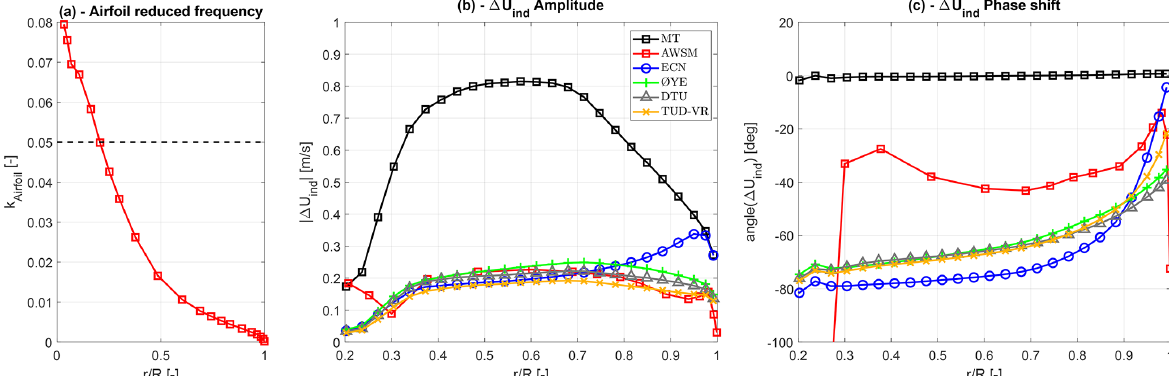
Figure 7. Spanwise distributions for the 50mHz sinusoidal pitch variation near rated conditions (a) of the reduced airfoil frequency; (b) of the axial induced-velocity variation amplitude at the blade pitch frequency; and (c) of the axial induced-velocity variation phase at the blade pitch frequency, with respect to the phase of the prescribed pitch time series.